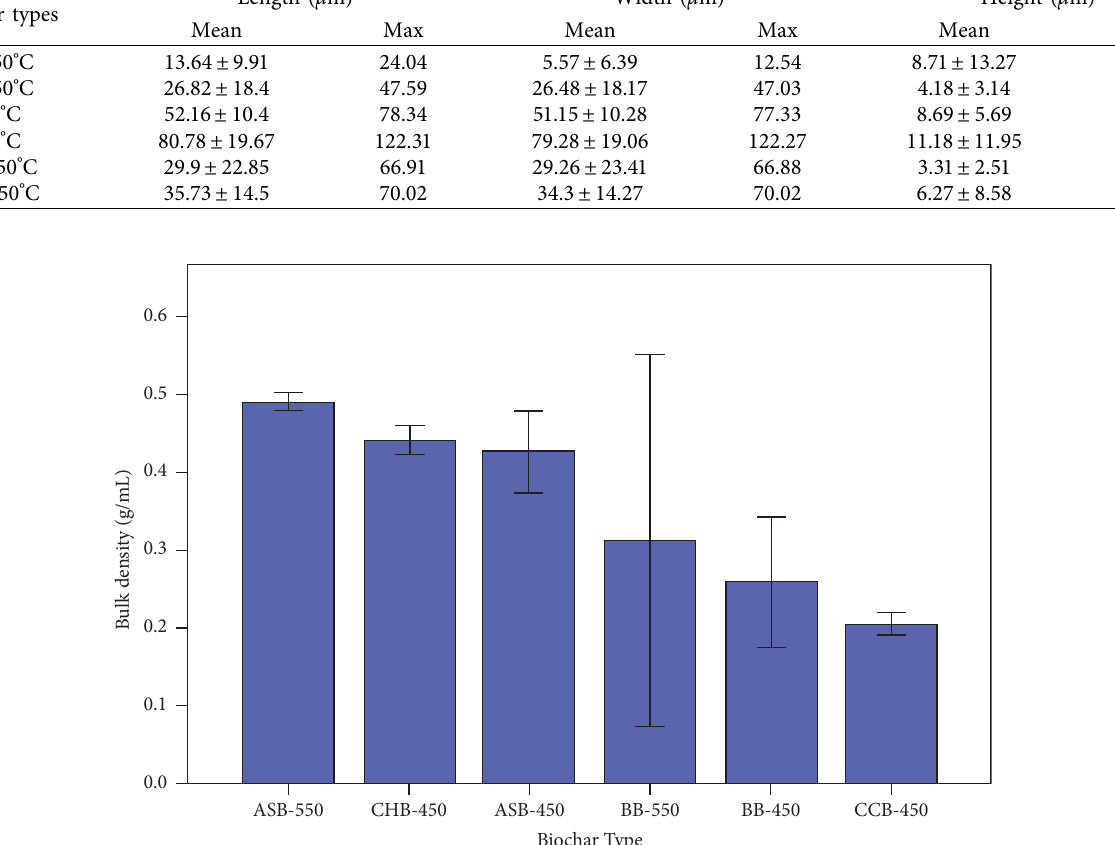
Table 1: Measurement of pore size after scanning the biochars in this study. Biochar